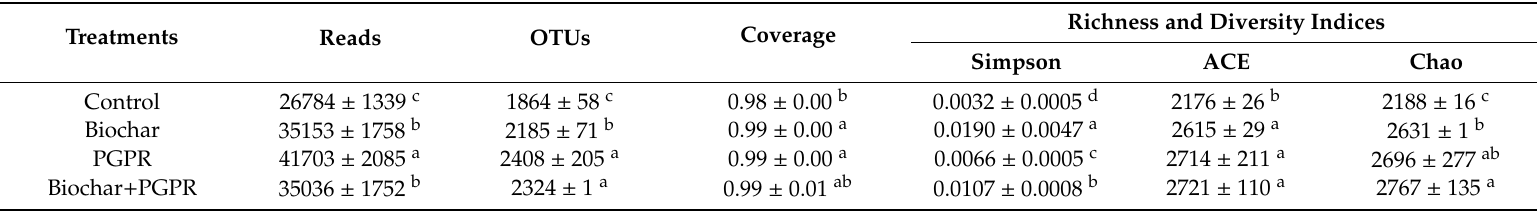
Table 5. Means and standard errors of the number of observed operational taxonomic units (OTUs) (at 97% similarity), richness, diversity, and coverage of soil bacteria. Di ff erent lowercase letters showed significant di ff erence at p < 0.05 among treatments and the